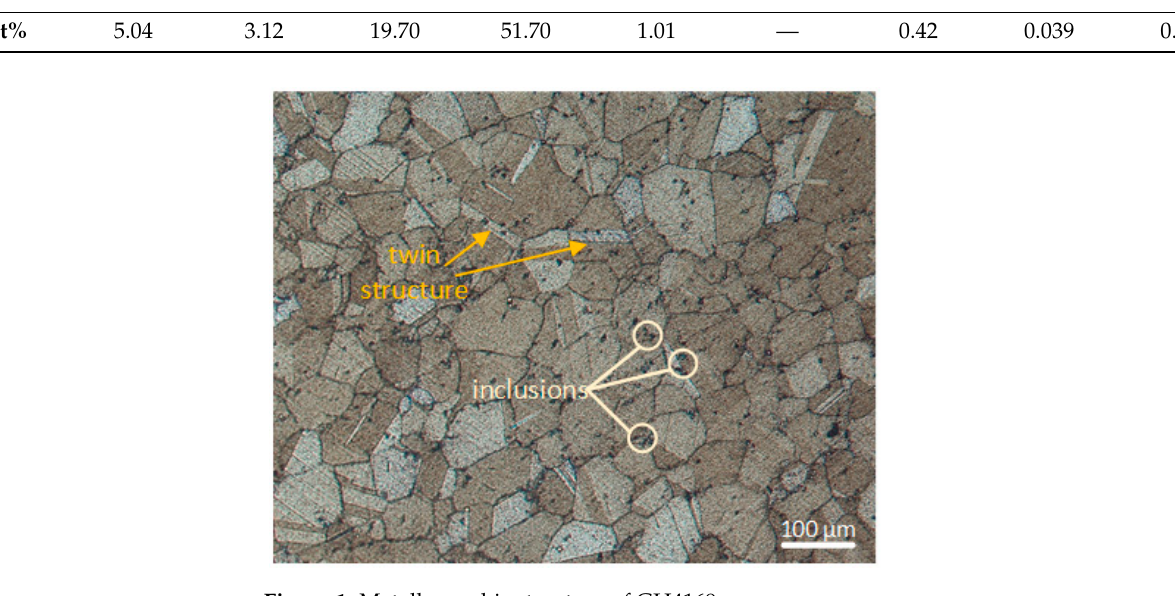
Figure 1. Metallographic structure of GH4169.